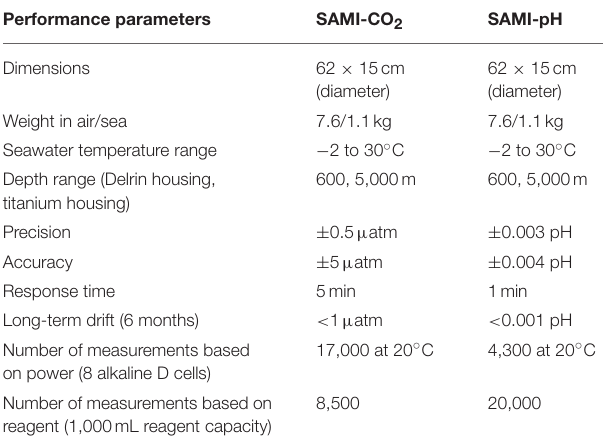
TABLE 1 | Summary of SAMI Performance